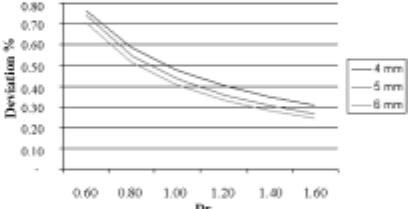
Fig. 3 - Mean percentage of the flow redirected by the graft n respect to the diameter and the ratio between the diameters of the subclavian artery and graft. The flow is favored with a greater diameter of the graft compared to the subclavian artery (ratio greater than 1)